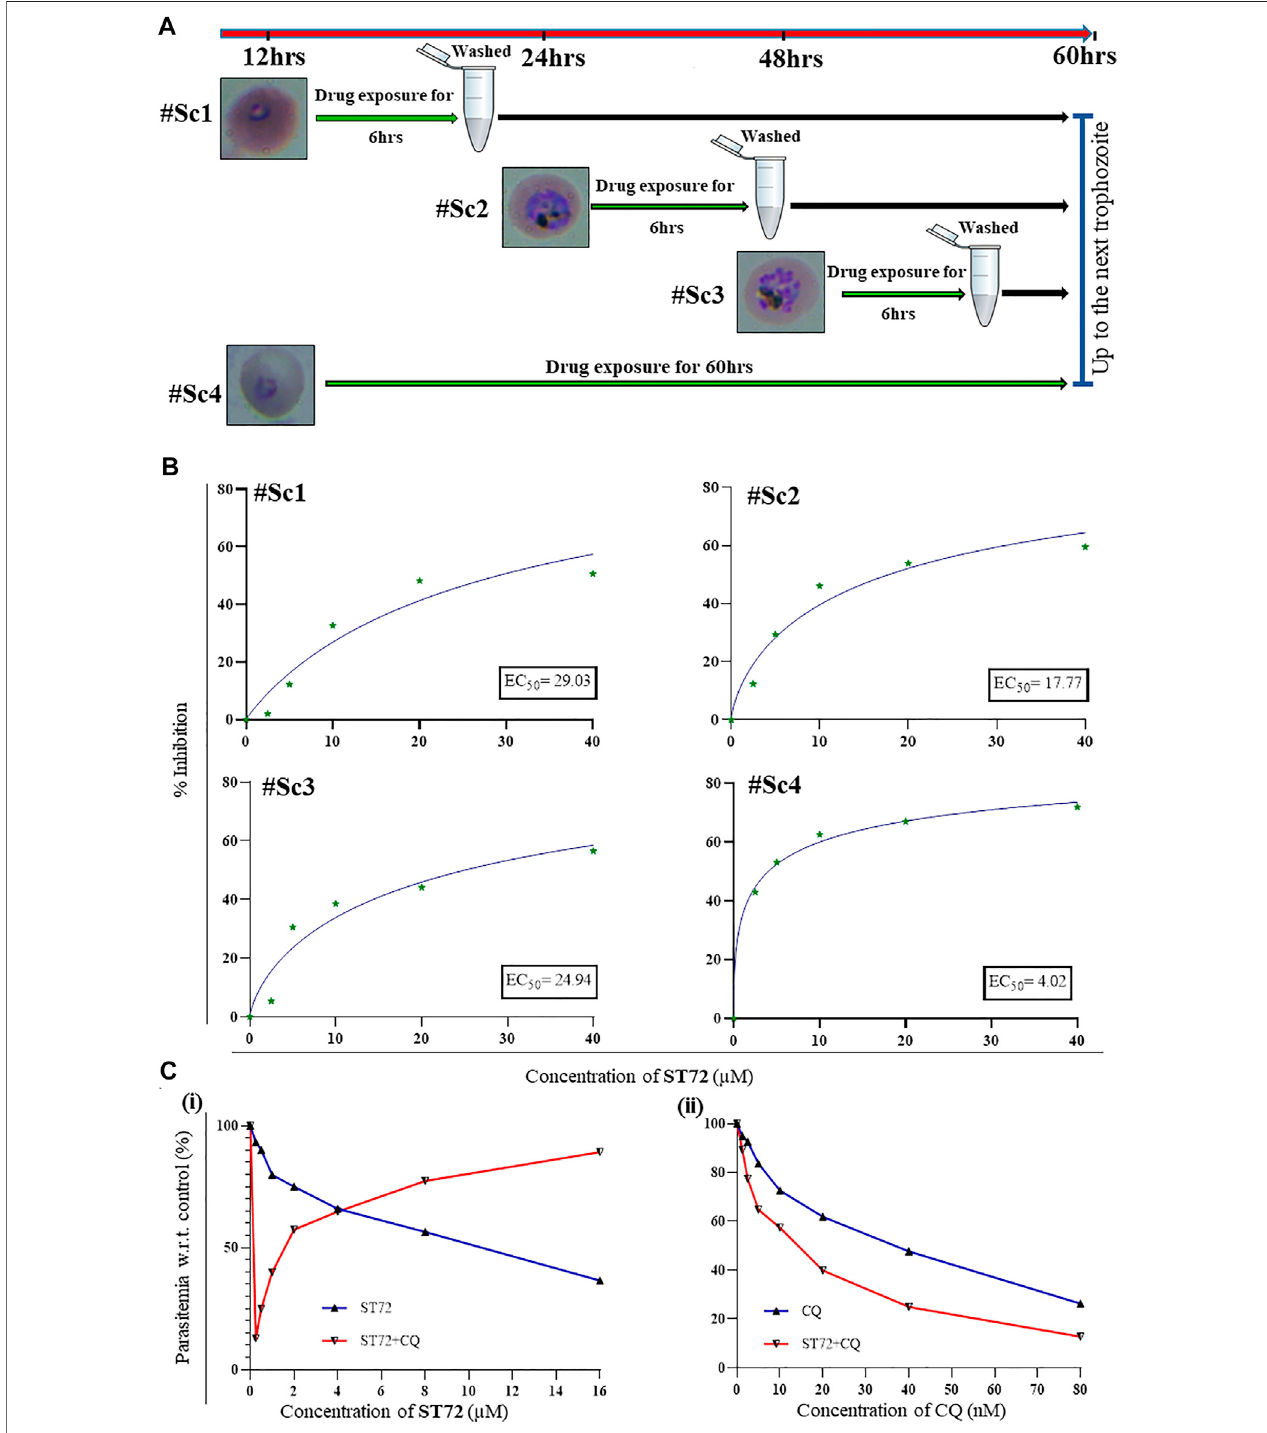
FIGURE4| Stage-speci fi csusceptibilitypro fi leforST72against3D7. (A) SchematicrepresentationshowingparasitesatdifferentstageswereexposedtoST72for 6 hrs. Growth was monitored at 60 h s post-treatment assessed by SYBR Green. (B) The graphs indicate the percentage growth inhibition by ST72 in a dose- dependent manner. IC 506hrs values were calculated using GraphPad software. (C) Drug combination assay exhibiting the effect of ST72 on growth of malarial parasites when tested in combination with chloroquine (CQ) or both drugs alone. Graphs (i) and (ii) represent growth patterns of parasites treated with these compounds individually and in combination, for 72 hrs. The concentrations of individual compounds used in the combination assays are included for each data point.